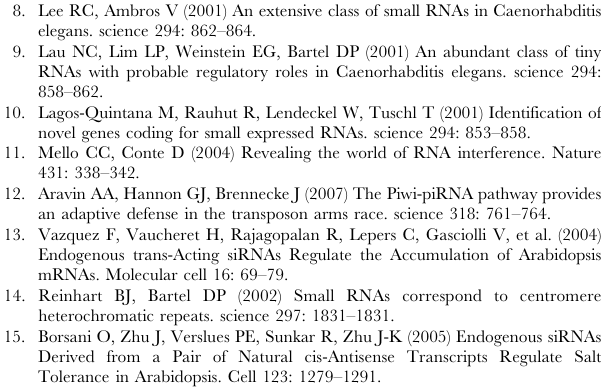
Figure S1 Flow chart of small RNA analysis and milRNA prediction. Figure S2 Chromosomal distribution and nucleotide bias of small RNAs. A: Chromosomal distribution of unknown reads. B: Length distribution of rRNA-derived small RNAs. Nucleotide biases at both ends of clean reads (C), mapped reads (D), unknown reads (E) and rRNA-derived small RNAs (F). G: Histograms of small RNA coverage on fox-milRNA precursors. Base coverage was counted and recorded when mapping small RNAs onto genome. Short bars indicate the location of mature milRNAs. The asterisk represents the milRNA* sequence. Figure S3 Alignment of the fox-milRNA-4 precursors in 11 Fusarium species.